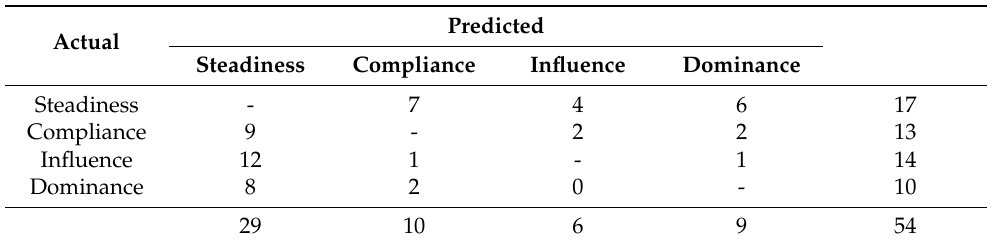
Table 14. Classification errors for AdaBoost with